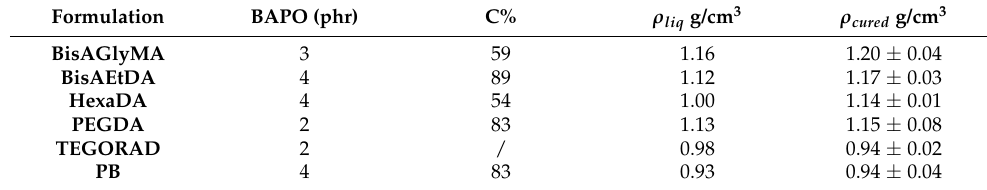
Table 2. Optimized BAPO amount for each formulation and density evaluation. The solvents used for the density investigation were: distilled water (H 2 O di ) for BisAGlyMA and BisAEtDA, and ethyl alcohol (EtOH) for all